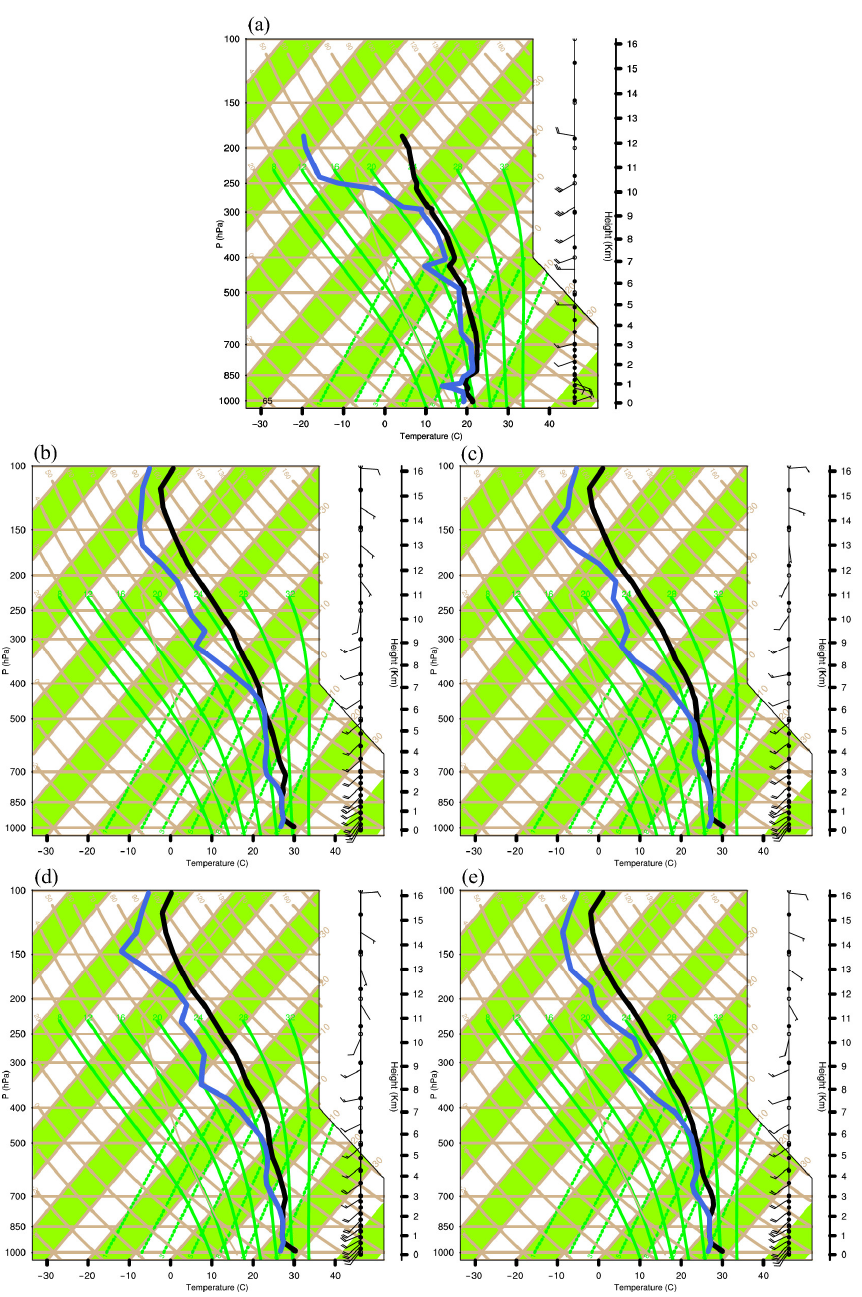
Figure 6. Skew-T plots from ( a ) the sounding at Shanghai station, ( b ) AMSU experiment, ( c ) MHS experiment, ( d ) MWHS experiment, ( e ) ALL experiment at 1200 UTC on 22 July 2018.